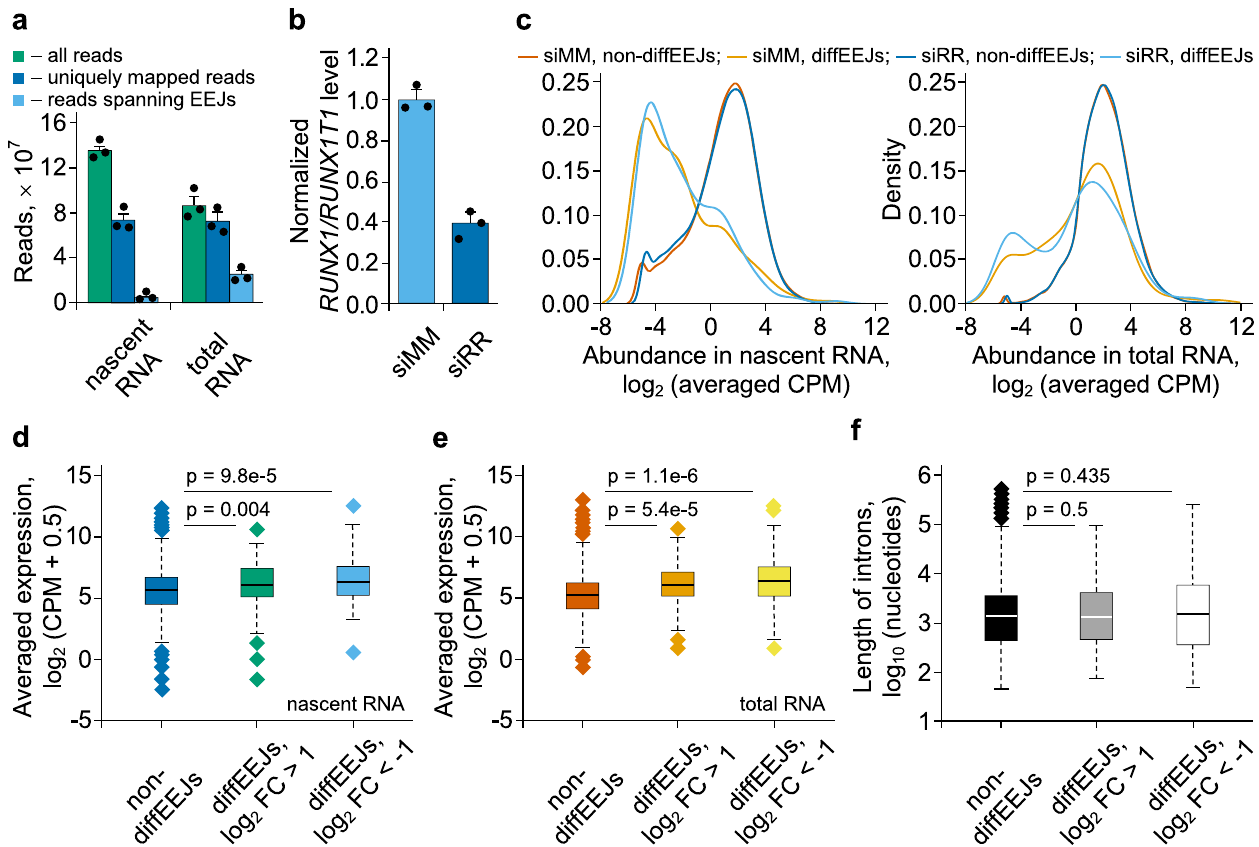
Fig. 5 Formation of diffEEJs in Kasumi-1 cells is delayed compared to non-diffEEJs. a The basic alignment statistics for the nascent RNA and total RNA datasets obtained from the siMM-treated leukemia cells. Bars represent mean ± SD of three independent experiments. Very similar results were observed with siRR-treated cells. b siRNA-mediated knockdown of RUNX1/RUNX1T1 as measured by nascent RNA expression. Bars represent mean ± SD of three independent experiments. c Multidensity plots of the abundance of EEJs identi fi ed in the nascent RNA (left panel) or total RNA (right panel). These plots are based on the RNA-Seq data obtained from the siMM-treated or siRR-treated leukemia cells. All EEJs identi fi ed at the level of nascent RNA and total RNA were grouped (see main text for further explanation of classi fi cation procedure) into non-diffEEJs or diffEEJs, and the abundance of these events was plotted. Each line represents the data averaged over the three independent biological replicas. d Expression of genes without (non-diffEEJs genes, n = 10851) or with differential splicing (upregulated or downregulated diffEEJs genes, n = 85) at nascent RNA level. e Expression of genes without (non-diffEEJs genes, n = 9836) or with differential splicing (upregulated or downregulated diffEEJs genes, n = 150) at total RNA level. f Comparison of intron lengths between non-diffEEJs ( n = 104925) and diffEEJs ( n = 177). In d , e , and f , boxplots summarize the expression data averaged over the three independent biological replicas. In each boxplot, horizontal line represents the median of expression distribution, box shows the interquartile range, and whiskers are the minimum and maximum. P -values were calculated with two-sided Mann – Whitney U